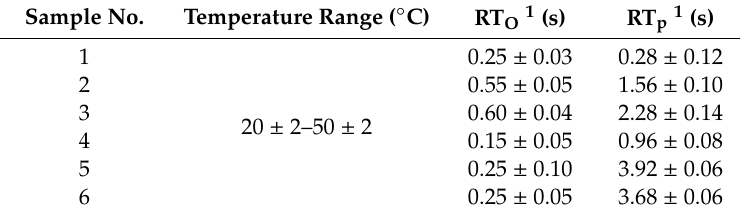
Figure 7. Response time of all the samples in oil bath ( a , b ) and on hotplate ( c , d ). Table 3. Response time of all the samples in oil-bath and hotplate conditions.